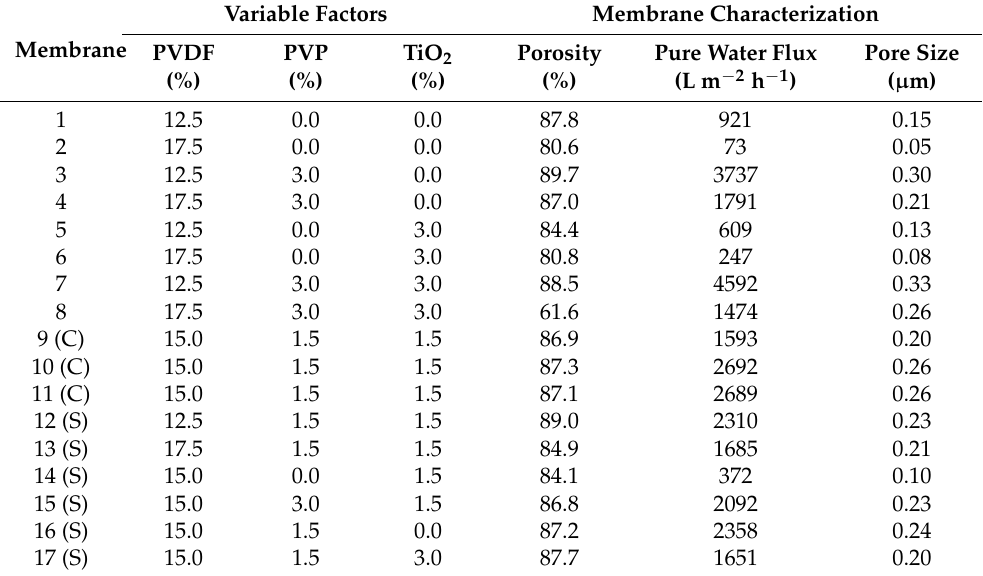
Table 6. Fabrication conditions according to the central composite design and characterization results of the modified membranes (17 experiments: 2 3 = eight experiments + three (C) center points + six (S) star-points).